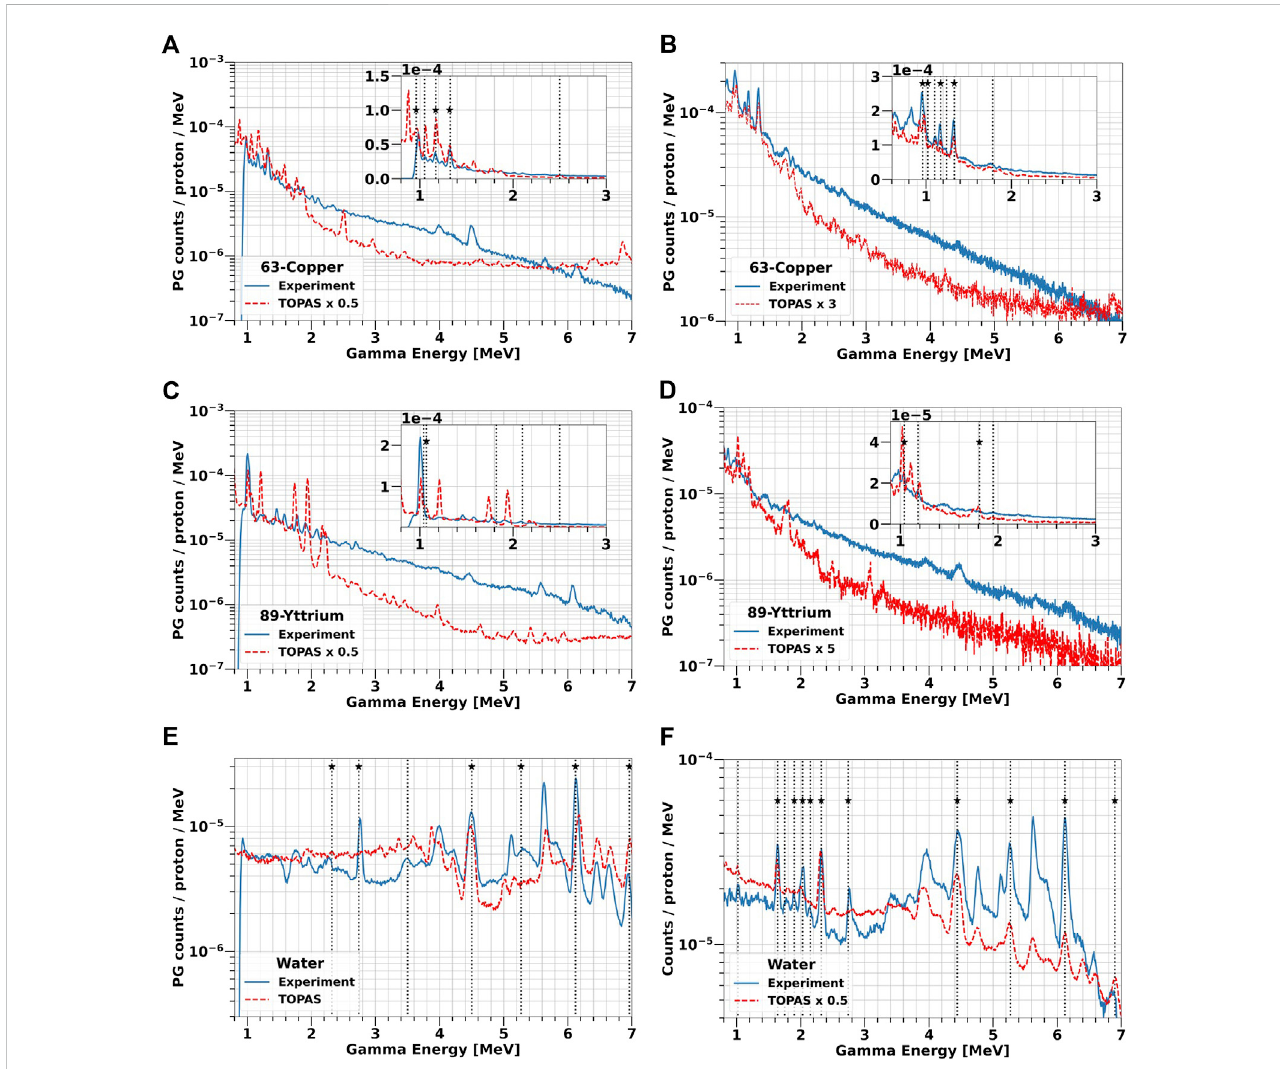
FIGURE 7 PG energy spectra from solid 63-Copper and 89-Yttrium targets and water irradiation at 25 MeV (A, C, E) and 70 MeV (B, D, F) proton beam. The experimentaldataareplottedasbluesolidlines,whileTOPASsimulationsarereportedasreddashedlines.Theboxesin (A – D) containazoomofthespectrain the low-energy region between 1 and 3 MeV. The vertical lines indicate all the PG peaks experimentally detected, while the stars mark those predicted by TALYS (Table